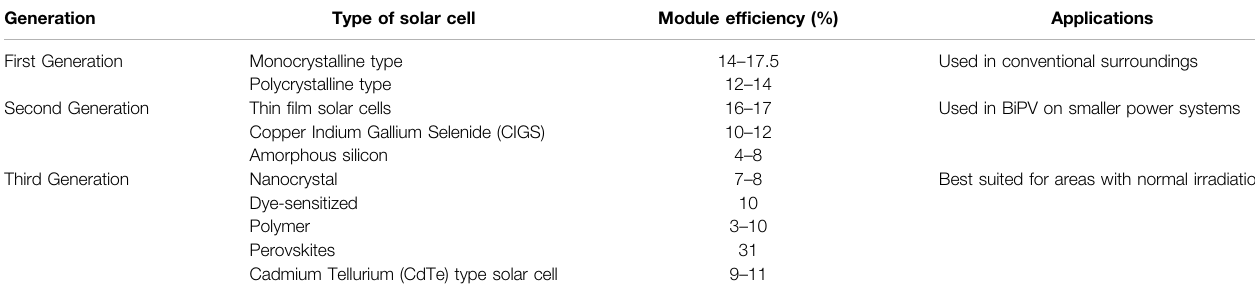
TABLE 1 | Comparison of Ef fi ciency with different generations of cells. Generation